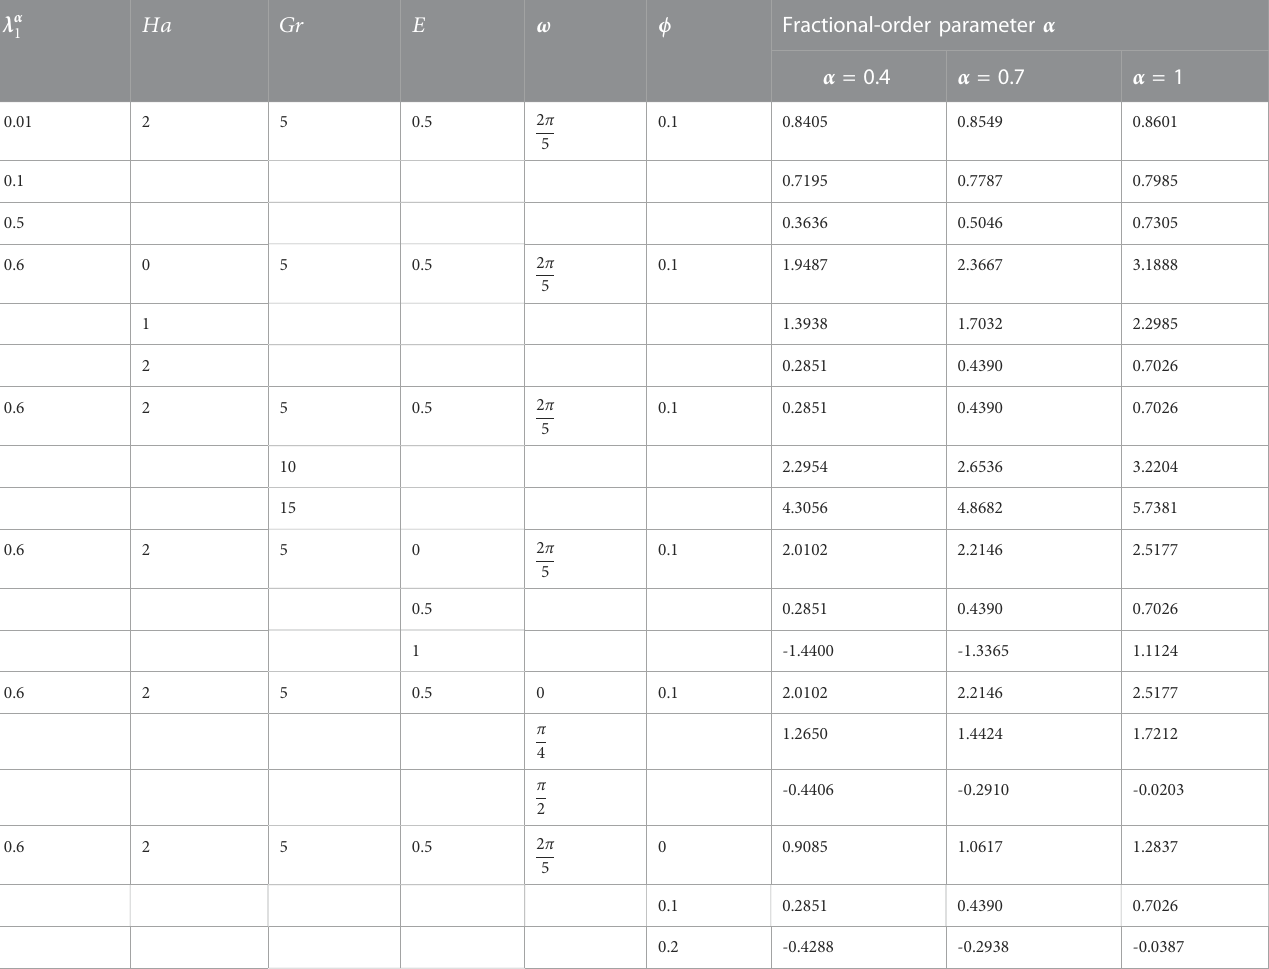
TABLE 2 Variation in the skin friction coef fi cient with respect to varying physical parameters and α .